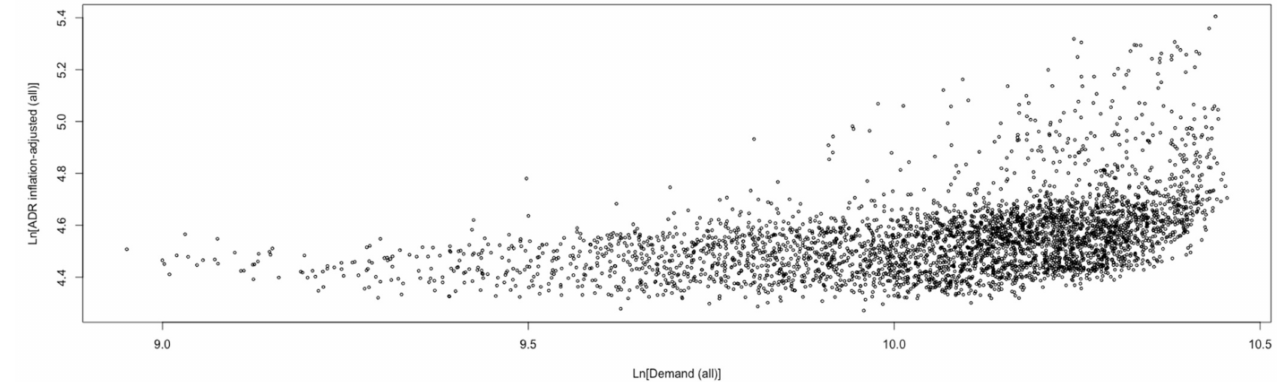
Figure 3. Scatterplot of hotel room demand and inflation-adjusted ADR in Vienna for hotel class ‘all’. Source: STR SHARE Center, own illustration using